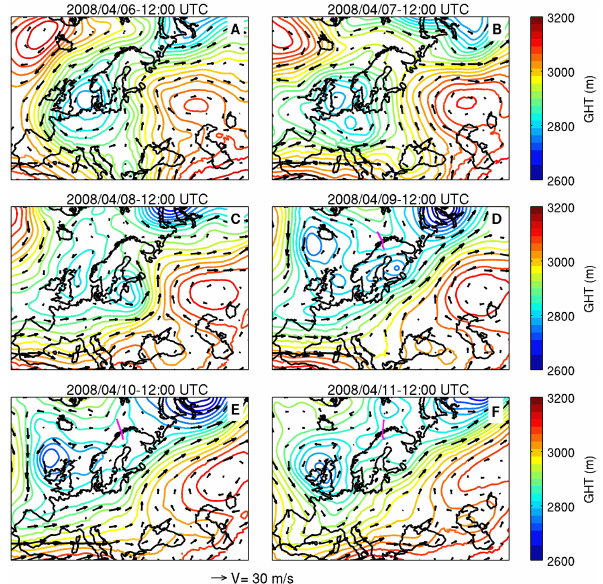
Figure 3. Meteorological conditions simulated by WRF-Chem dur- ing the POLARCAT-France spring campaign period, represented by the 700hPa geopotential height (contour lines) and 700hPa wind vectors (30ms − 1 vector given for scale) on 6–11 April 2008 (12:00UTC). The POLARCAT-France flight tracks on 9, 10, and 11 April 2008 are indicated in magenta.